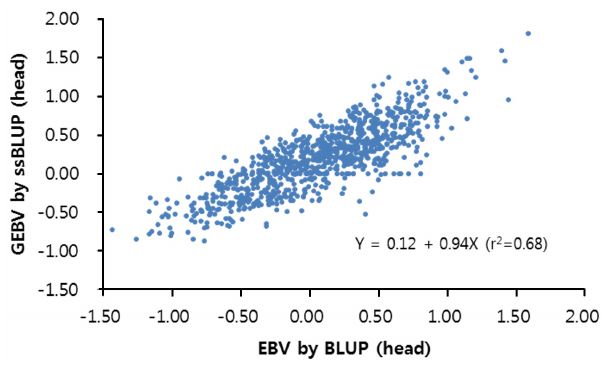
Figure 1. Correlation between estimated breeding value (EBV) and genomic estimated breeding value (GEBV) for the total number of piglets born